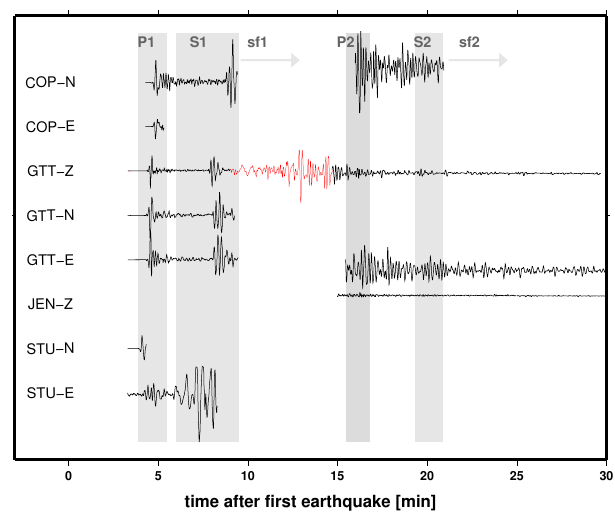
Figure 7. Usable waveforms (black) of the first earthquake show P waves arriving 4–6min and S waves 6–8min after origin time, while body waves of the second earthquake (15–20min) are hidden in the surface wave coda of the preceding earthquake. The continu- ously digitized waveform of the Z component at station GTT (red) is clipped during the recording of the surface waves of the first event at 13min (negative offset).